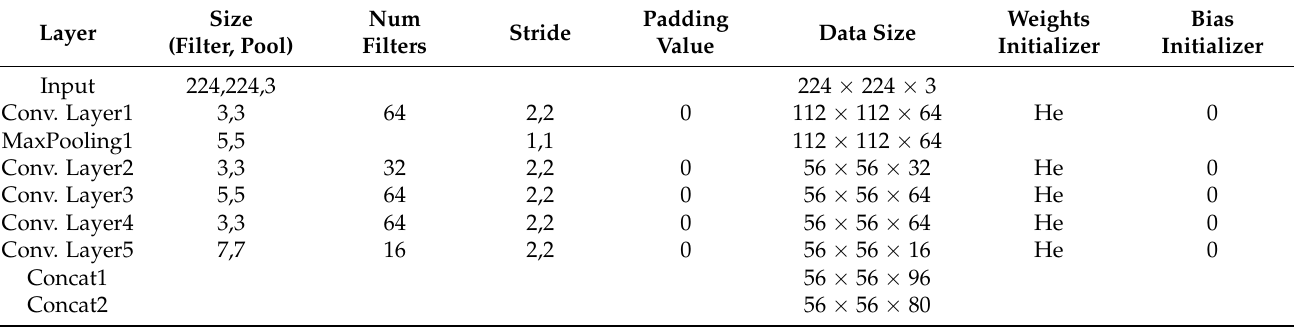
Table 1. Layer Parameters in Figure